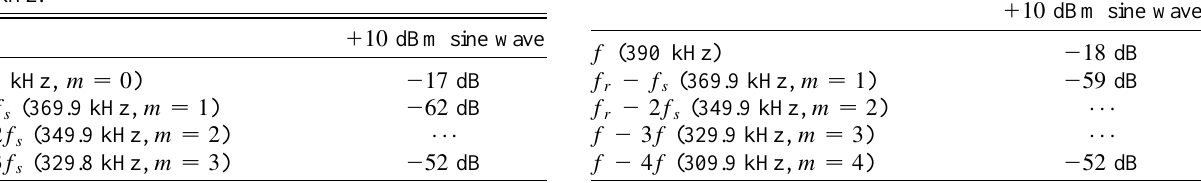
TABLE VII. The beam spectra amplitudes from the spec- trum analyzer when modulating the phase of the rf voltage at 329.9 kHz.